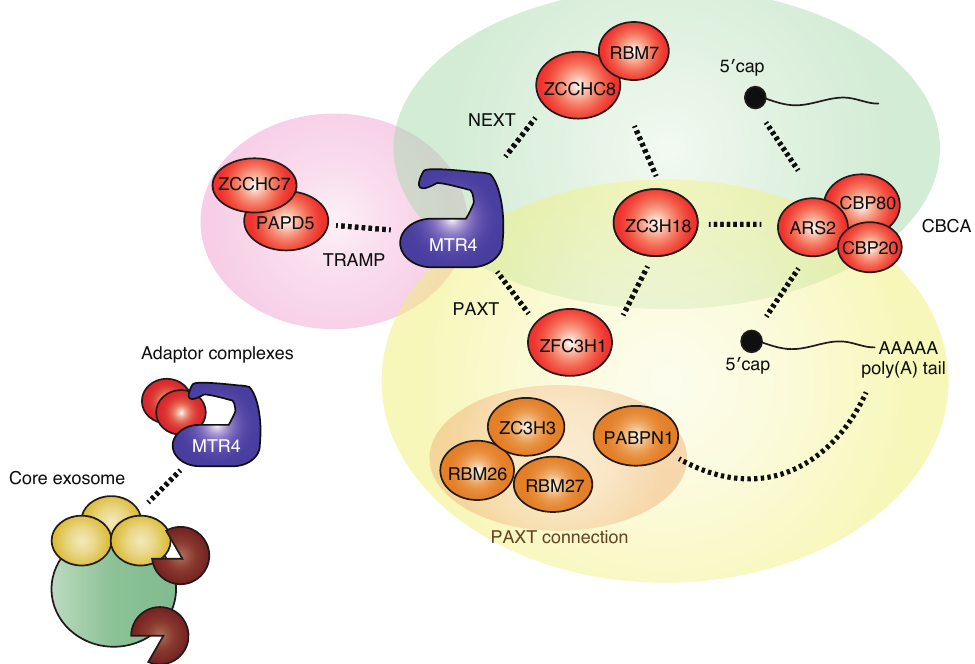
Figure 2. The human adaptor complexes guiding specific RNA substrates for exosome-mediated RNA degradation or processing. Note that the RNA helicase MTR4 is commonly present in all the adaptor